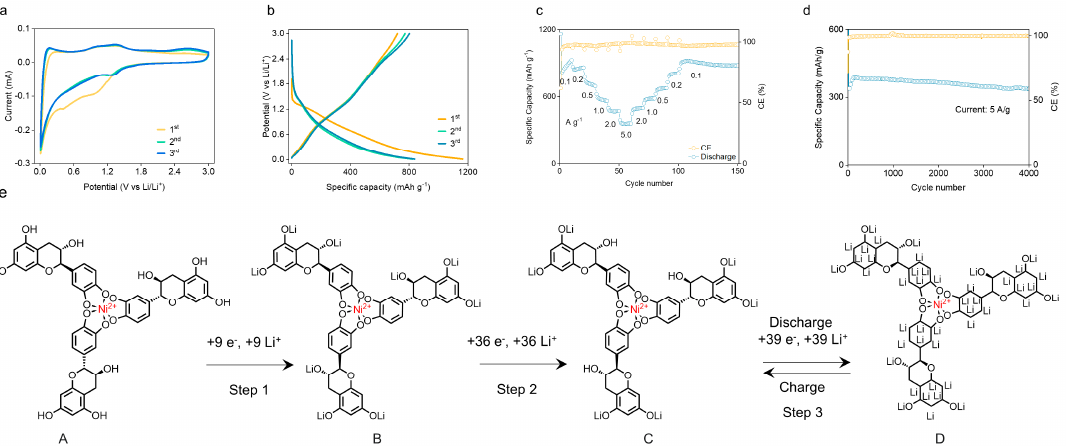
Figure 2. ( a ) CV curves of TP − Ni measured at a scan rate of 0.1 mV s − 1 in the voltage range of 0.01–3.0 V. ( b ) Charge/discharge curves measured at a current density of 0.1 A g − 1 from 0.01 to 3.0 V. ( c ) Rate performance of TP − Ni. ( d ) Long cycling performance measured at a current density of 5 A g − 1 . ( e ) The proposed mechanism for storing lithium in the TP − Ni anode.